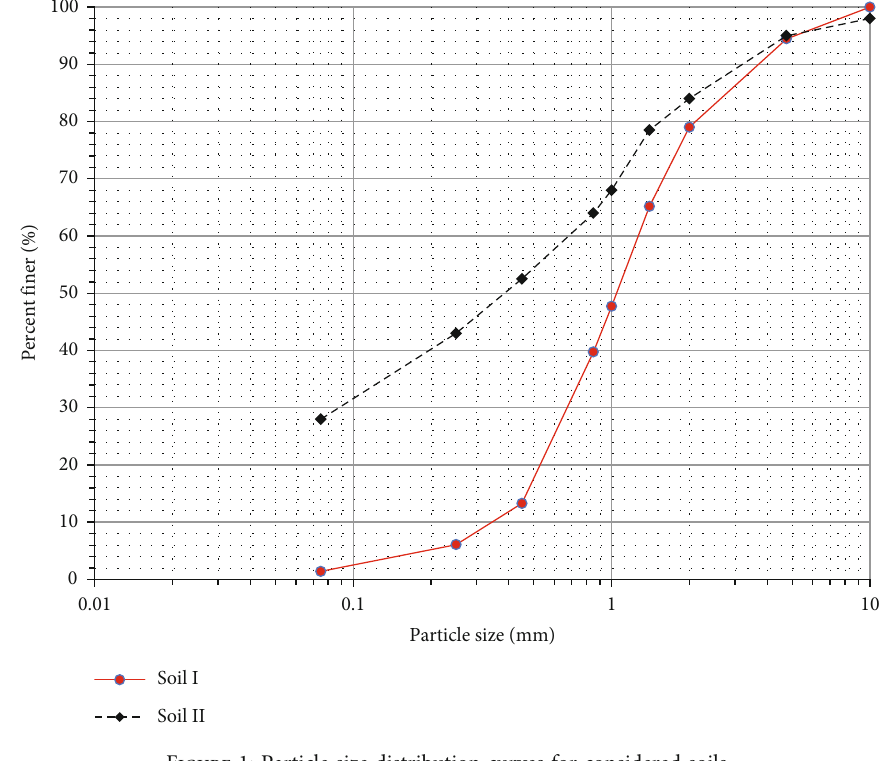
Figure 1: Particle size distribution curves for considered soils. Table 1: Hydrological properties of sands and study